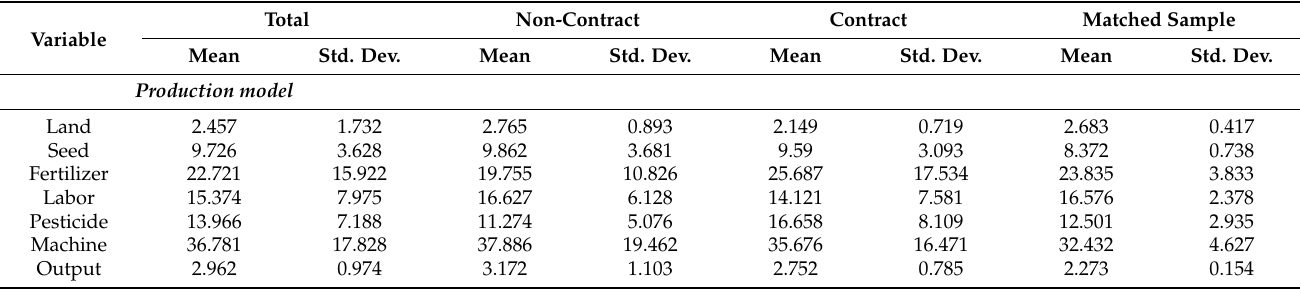
Table 2. Descriptive statistics for production and technical inefficiency